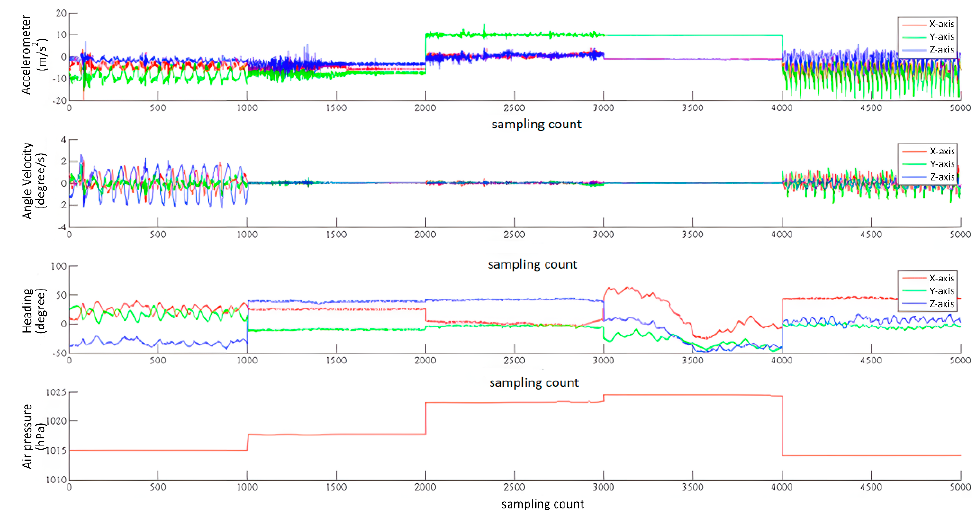
Figure 2. The data collected by accelerometer, gyroscope, magnetometer, and barometer.